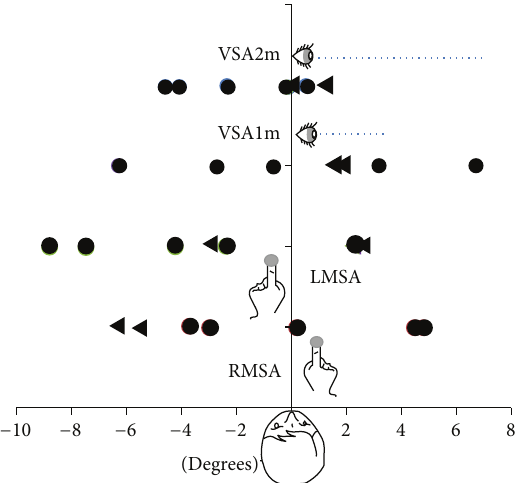
Figure 3: Initial reference frame evaluation for each patient (mea- sured at inclusion), in degrees of angle deviation from objective midline. No systematic bias was found in terms of CRPS side: most variables are fairly symmetrically distributed around the sagittal axis. The only significant trends were found for the healthy hand straight-ahead demonstration which was biased toward the left for both left (RMSA) and right (LMSA) CRPS. RMSA: manual straight- ahead for the right hand. LMSA: manual straight-ahead for the left hand. VSA1m: visual straight-ahead at 1 meter. VSA2m: visual straight-ahead at 2 meters. Circles: right CRPS. Triangles: left CRPS.